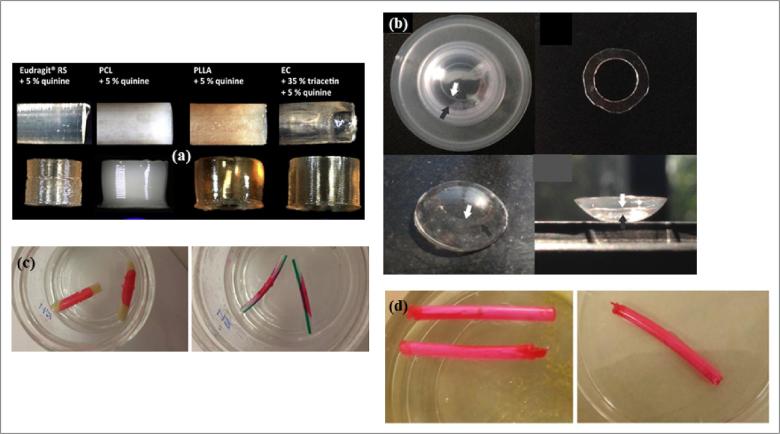
(a) Quinine loaded implantable matrix (adapted from Kempin et al., 2017), (b) hydrogel contact lenses for controlled drug delivery (adapted from Maulvi et al., 2016), (c) localized sustained release varnishes of thiazolidinedione-8, (adapted from Shenderovich et al., 2015) and (d) chlorhexidine sustained-release varnishes for catheter coating (adapted from Gefter et al., 2018) based on Ethocel™ polymeric derivatives.